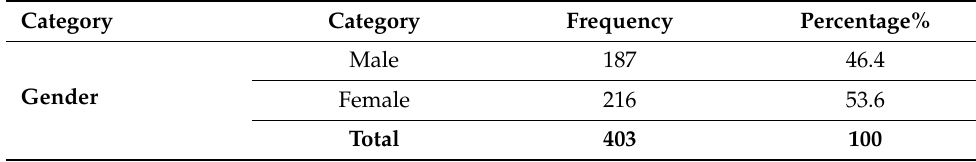
Table 2. Demographic of the